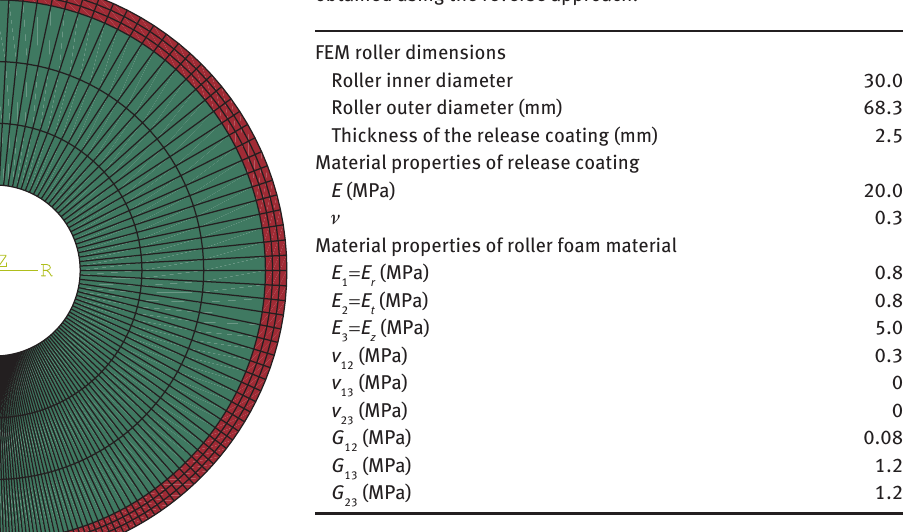
Table 3 Material parameters for the analogous FEM model obtained using the reverse approach.